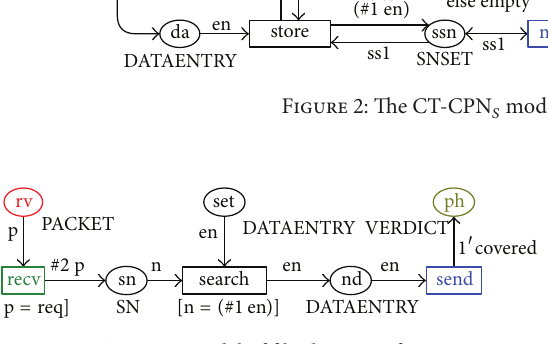
Figure 3: CT-CPN model of file sharing software system. TP